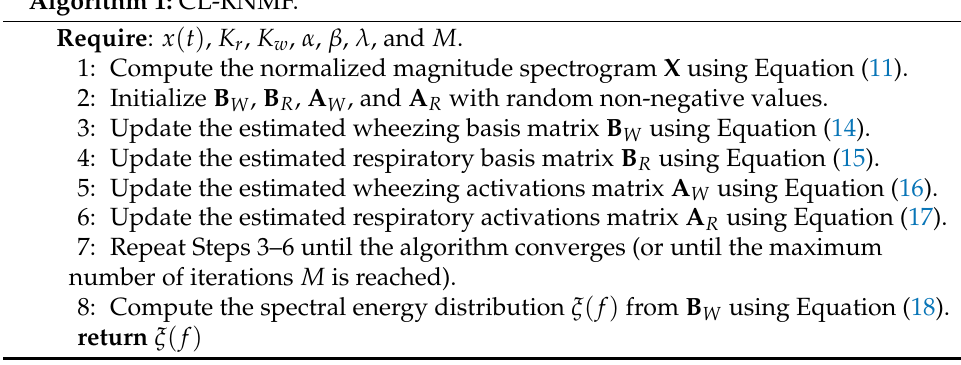
Figure 6. The spectral energy distribution ξ ( f ) provided by CL-RNMF from the estimated basis matrix B W shown in Figure 5: ( A ) Figure 5A. ( B ) Figure 5B. ( C ) Figure 5C. ( D ) Figure 5D. Algorithm 1: